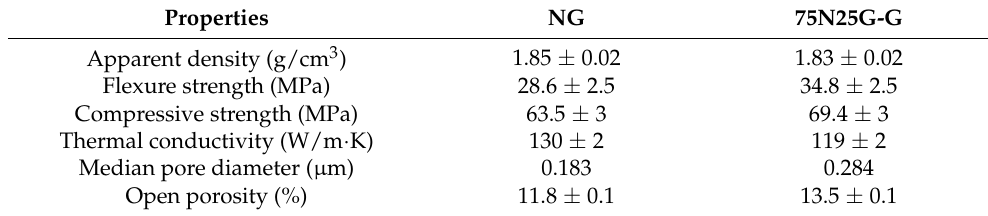
Table 1. Properties of NG and